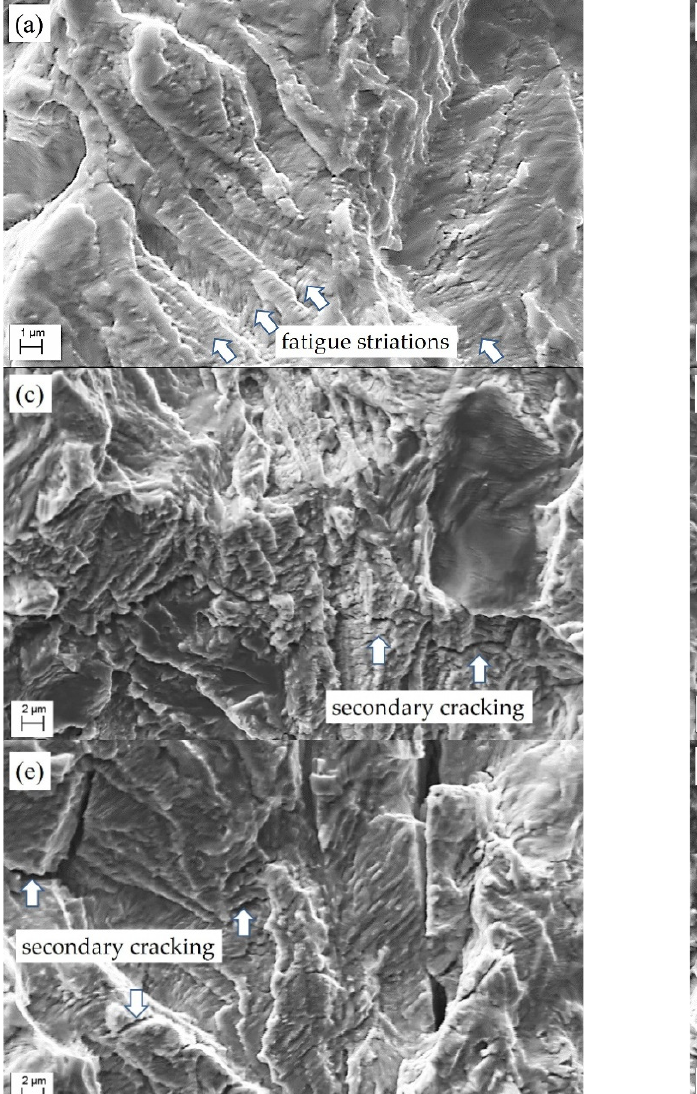
Figure 11. SEM fractography of specimens of 17H1S steel ( a , b ) in the AR state and ( c – f ) after LTO cut from the upper ( c , d ) and lower ( e , f ) parts of the corresponding pipe in the positions close to its inner surface and undergoing the FCG resistance test at a frequency of 10 Hz and a stress ratio of 0.5. The SEM images correspond to the Δ K level of about 32–35 MPa m 1/2 . Cleavage, inclusion and delaminations are indicated by arrows.